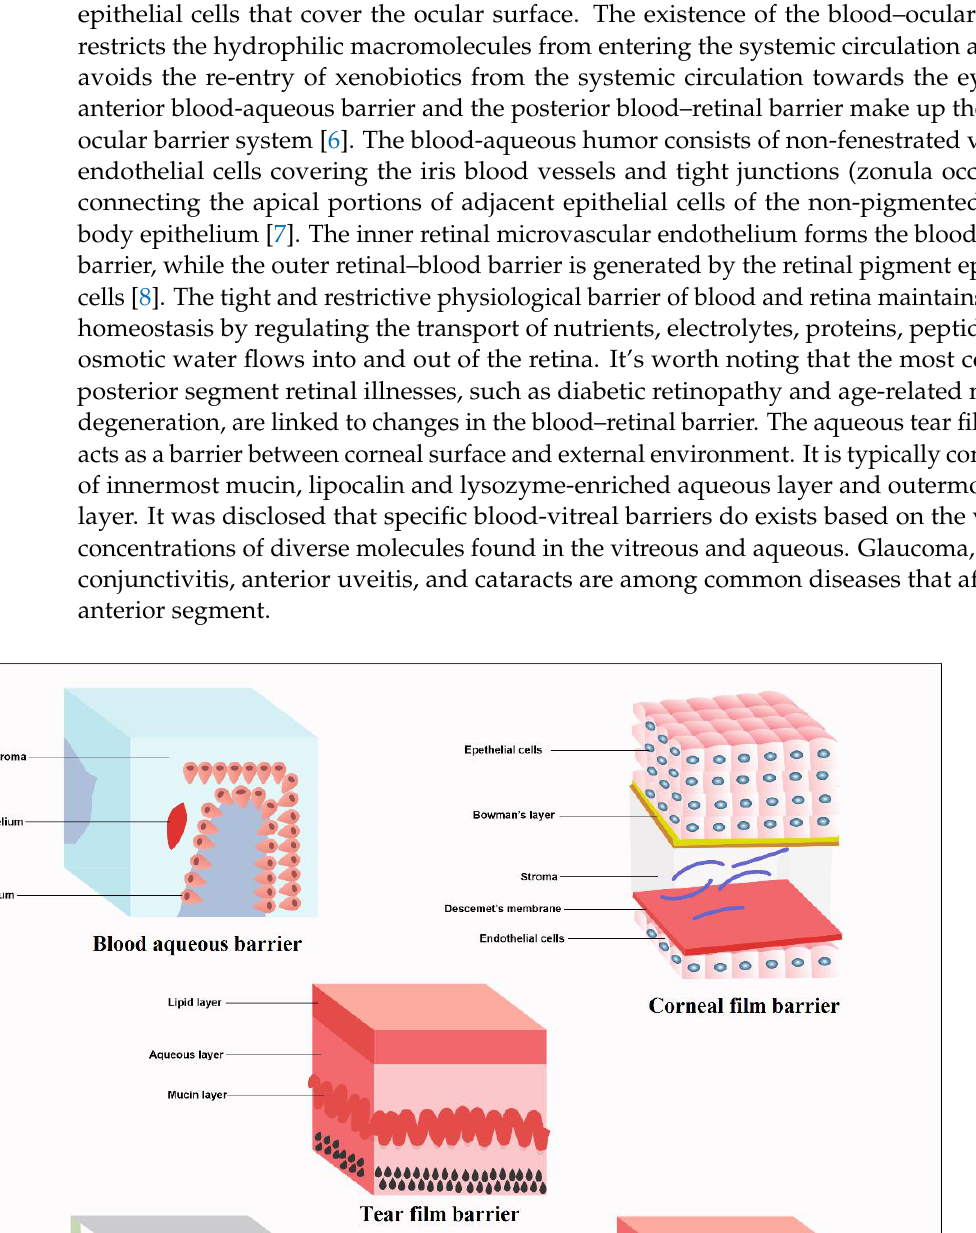
Figure 1. Schematic diagram depicting the key regions and various ocular routes of drug admin- istration in the human eye.